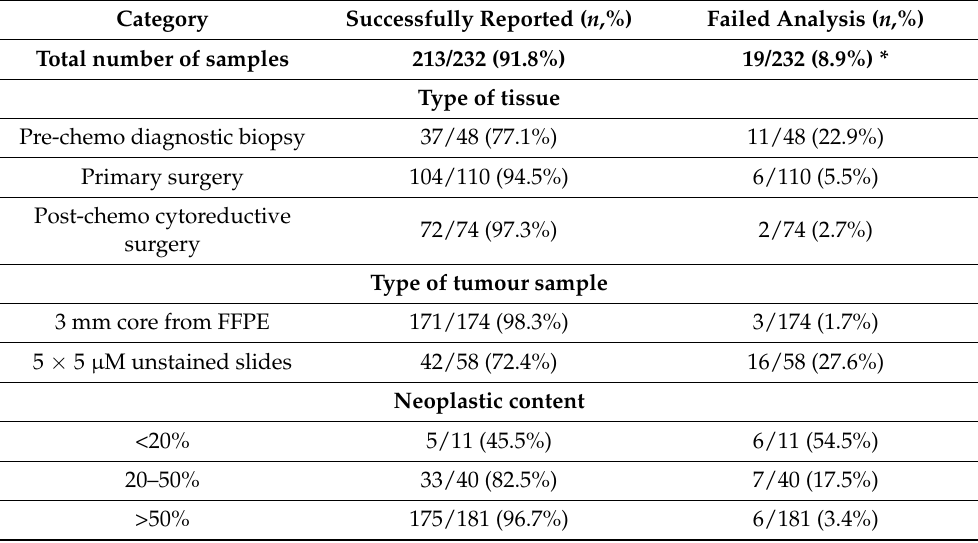
Table 4. NELCN tumour tissue BRCA1/BRCA2 next generation sequencing